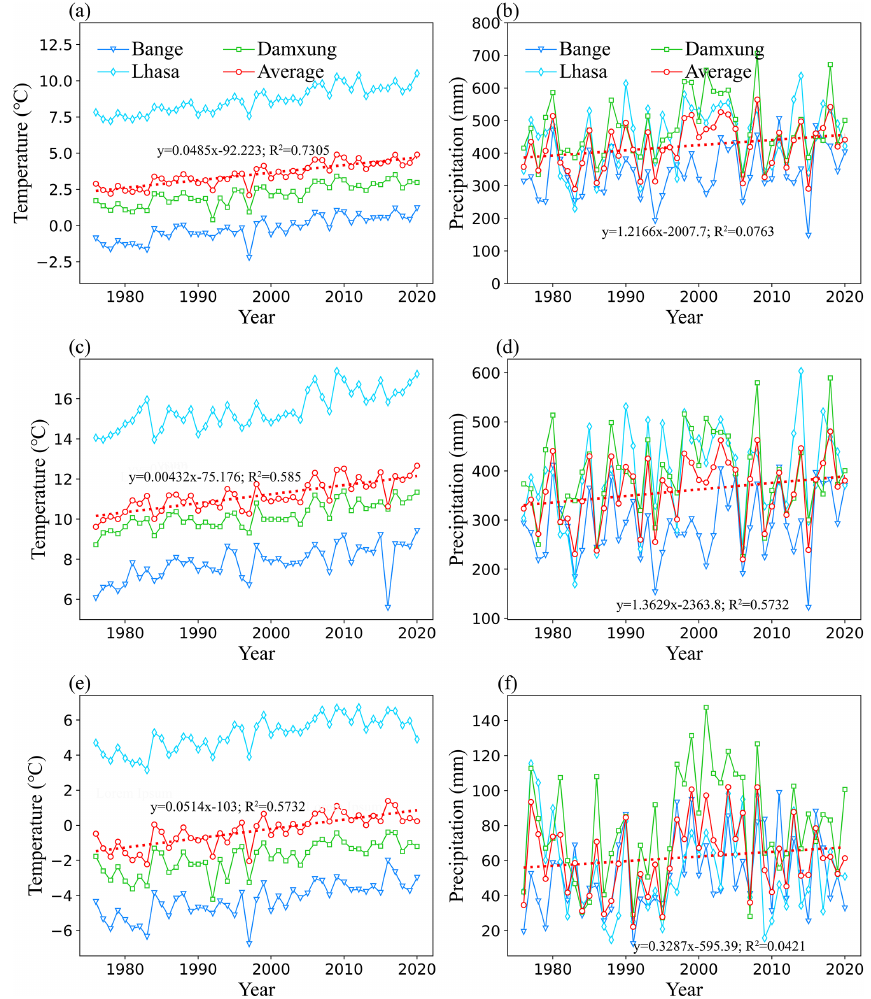
Figure 12. Temperature and precipitation changes for the study area at Damxung, Lhasa and Bange stations from 1976 to 2020. Annual aver- age temperature and precipitation (a, b) , ablation season (June to September) average temperature and precipitation (c, d) , and accumulation season (January to May and October to December) average temperature and precipitation (e, f)